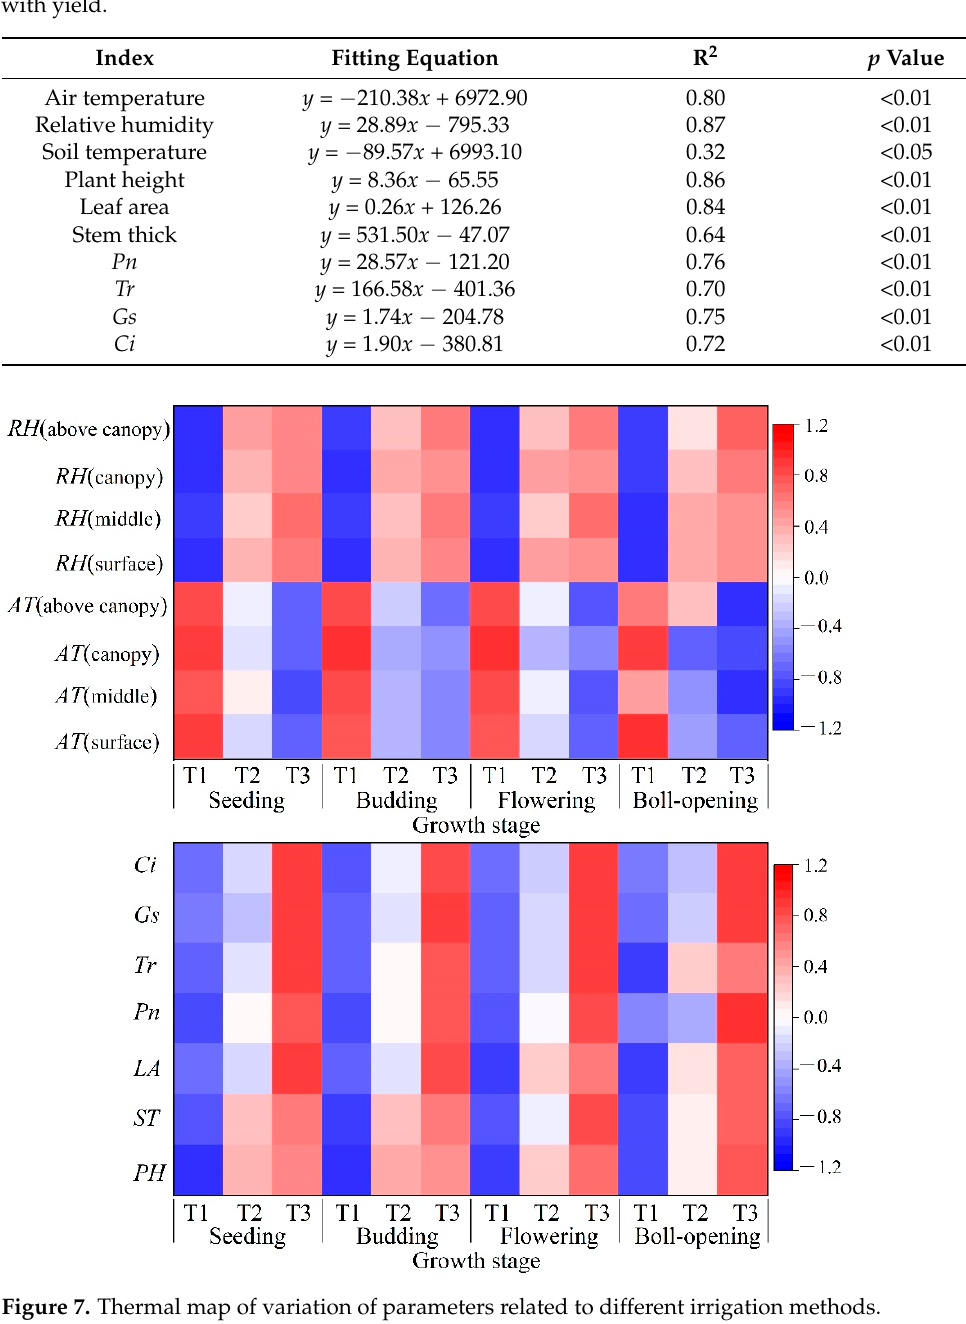
Figure 7. Thermal map of variation of parameters related to different irrigation methods.